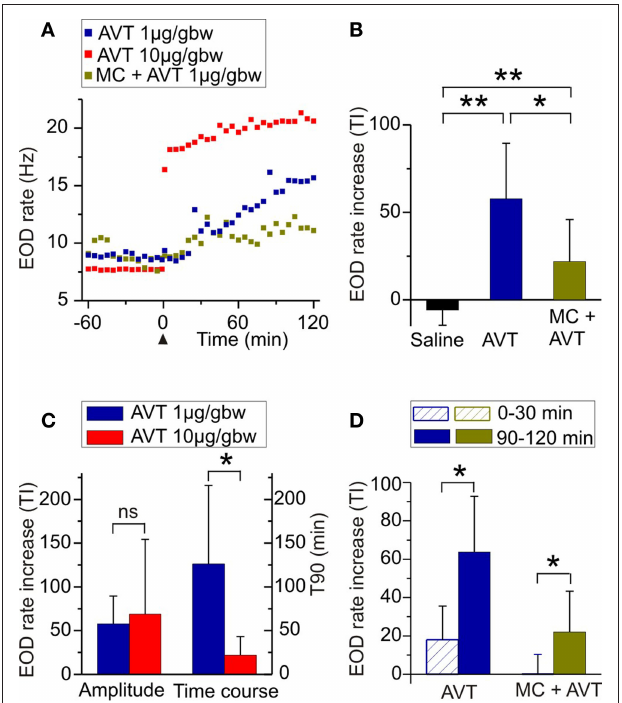
FIguRE 1 | Effects of AVT upon EOD rate in Brachyhypopomus gauderio during the non-breeding season. (A) EOD rate as function of time during daytime in representative individuals of different experimental groups: AVT (1 μg/gbw) in blue; AVT (10 μg/gbw) in red; and MC (AVT antagonist, 10 μg/ gbw) 5 min prior to AVT (1 μg/gbw) in green. Each treatment was administered at time = 0 (arrowhead). Each point represents the inverse (frequency) of the mean interval value in 10 s-long samples. (B) Amplitude of the increase of EOD rate induced by AVT (1 μg/gbw) compared to saline controls and to fish that received MC (10 μg/gbw) + AVT (1 μg/gbw). (C) Dose-response relationship of the effect of AVT (1 μg/gbw vs 10 μg/gbw) on the amplitude of EOD rate increase and on its time course. (D) Progression of the effects of AVT (1 μg/gbw) and of MC (10 μg/gbw) + AVT (1 μg/gbw) on the amplitude of EOD rate increase. Bars represent medians (IQR) of treatment indexes (TI, see Materials and Methods) and of the time it took for the effect to reach 90% of its maximal value (T90, see Materials and Methods) in (C) . * p < 0.05. ** p < 0.01. (B,C) Mann–Whitney U test. (D) Wilcoxon Matched-Pairs test.